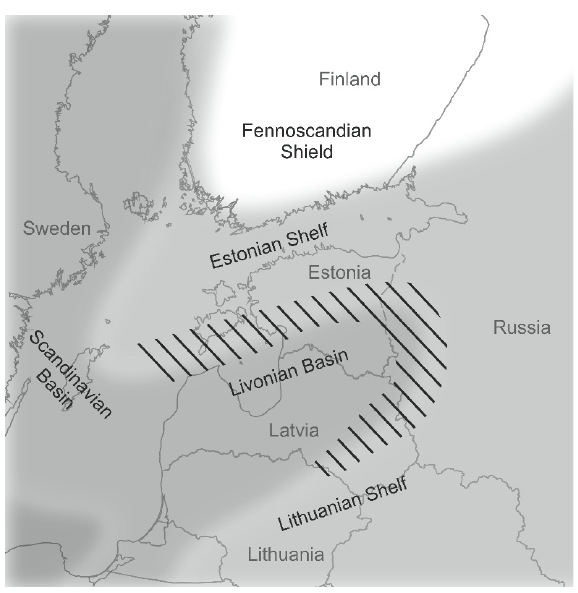
Fig. 1. Late Ordovician facies belts and major tectonic features of the Baltic region (after Jaanusson 1976). The striped area marks a transitional belt between the two principal facies (after Põlma 1967).